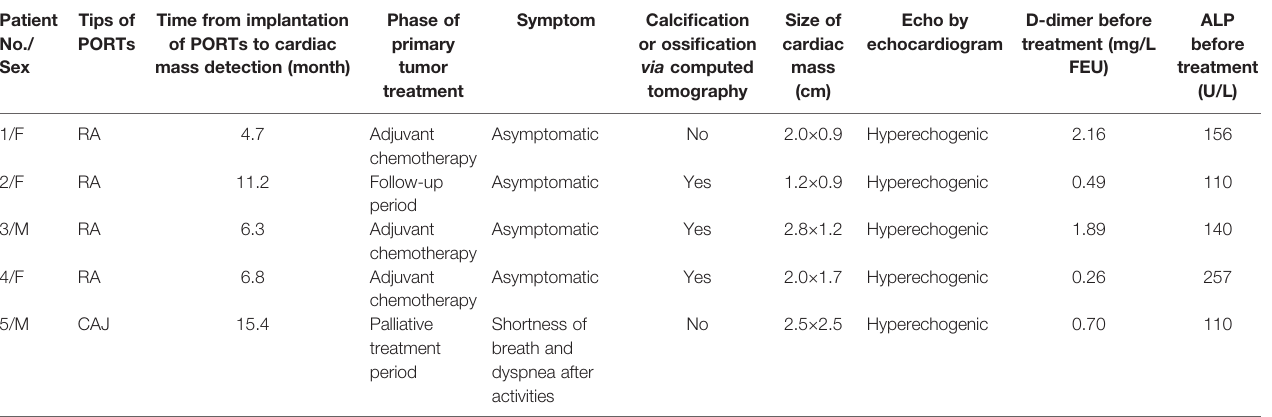
TABLE 2 | Features of cardiac masses in pediatric patients with bone sarcoma. Patient